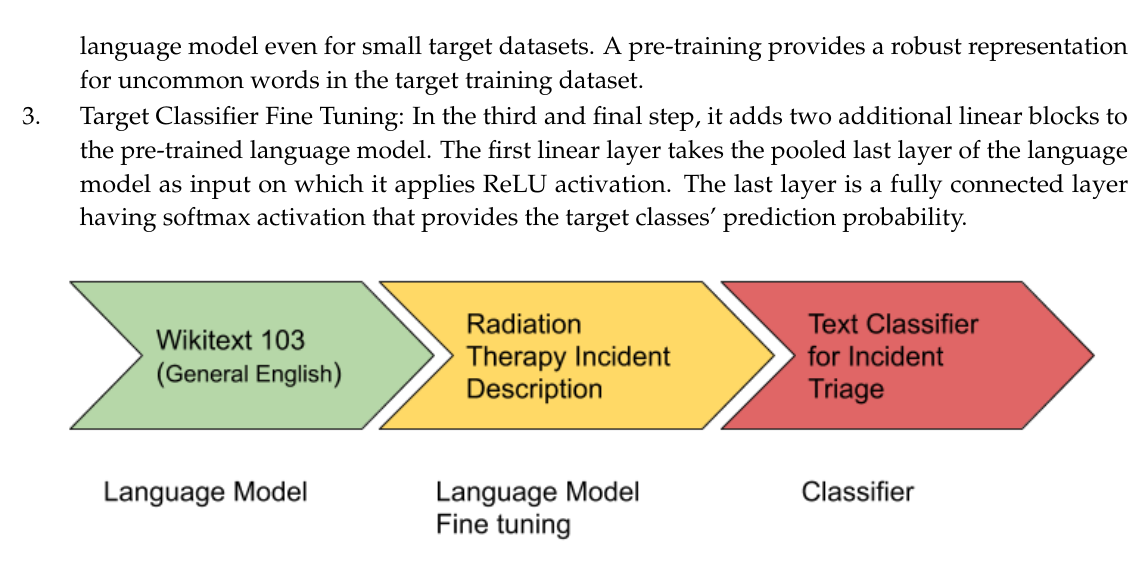
Figure 5. High level Universal Language Model Fine-tuning (ULMFiT) approach used for incident triage.